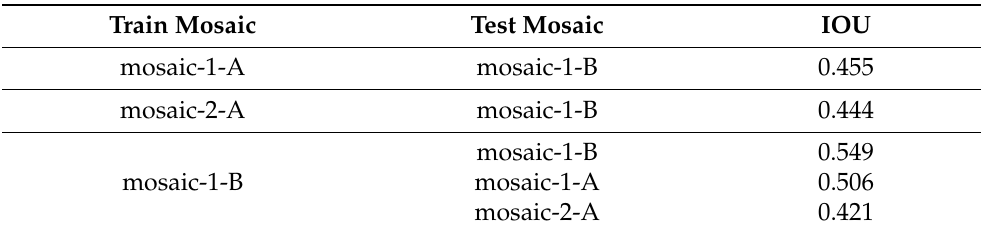
Table 5. The full shape segmentation performance by the IOU metric obtained when switching annotators-training using annotations of one and testing using annotations of